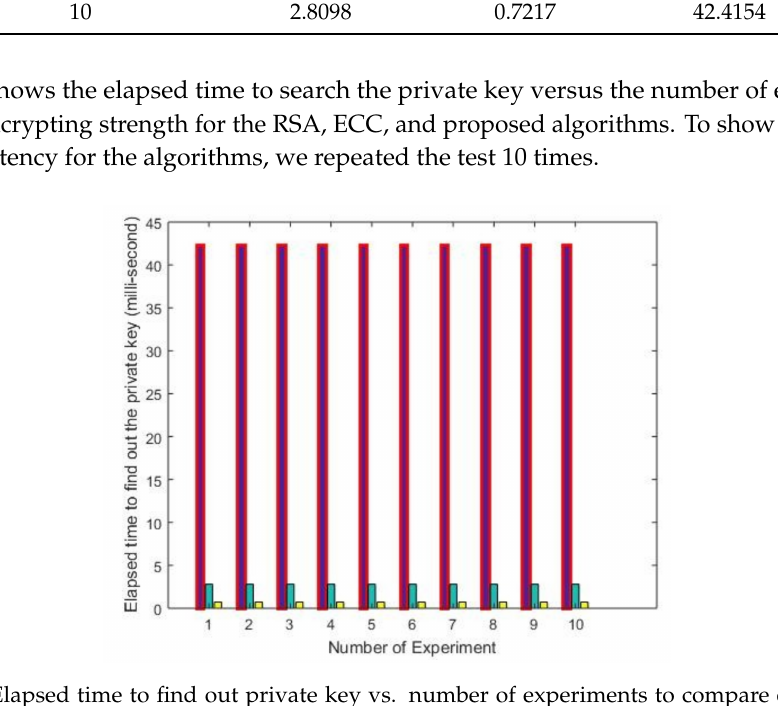
Figure 5. Elapsed time to find out private key vs. number of experiments to compare